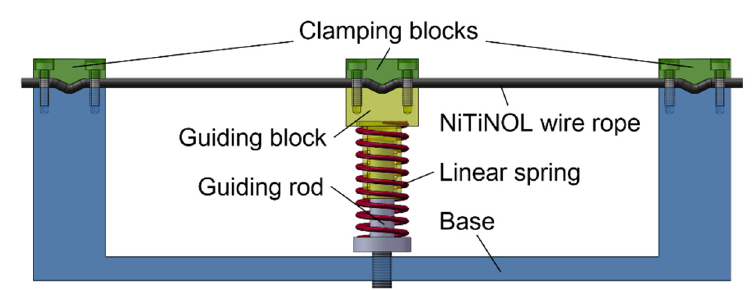
Figure 1. Vibration isolator with a NiTiNOL wire rope.